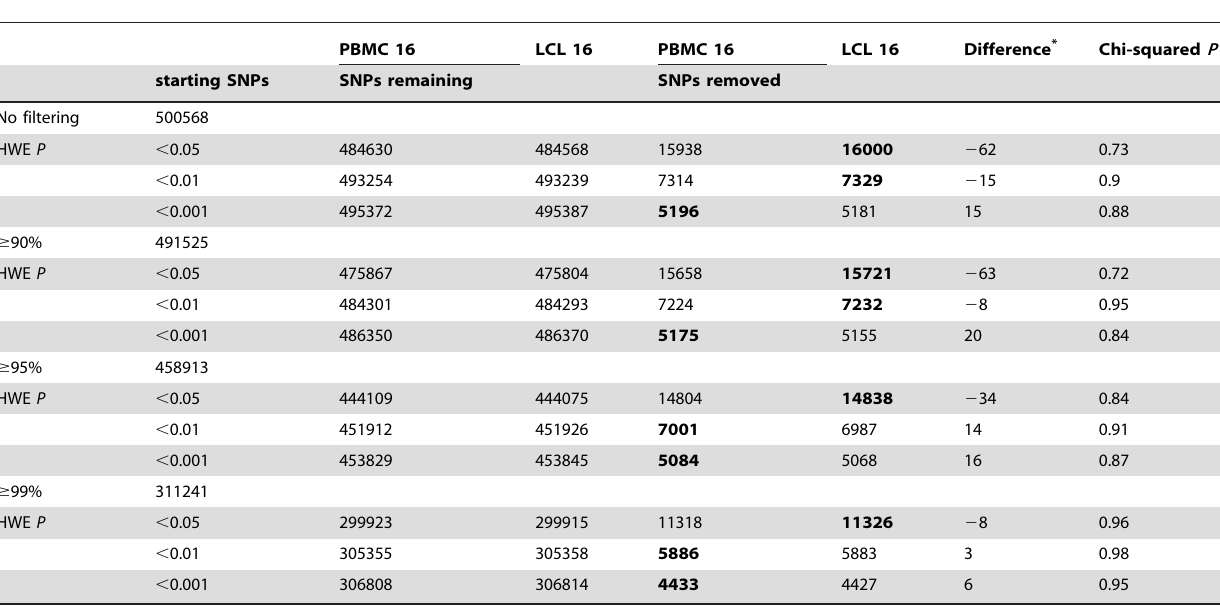
Bold text indicates the greater number of SNPs removed by Hardy-Weinberg filtering, in comparisons of PBMC and LCL sample populations. * Difference between PBMC and LCL 16 in the number of SNPs removed by Hardy-Weinberg equilibrium